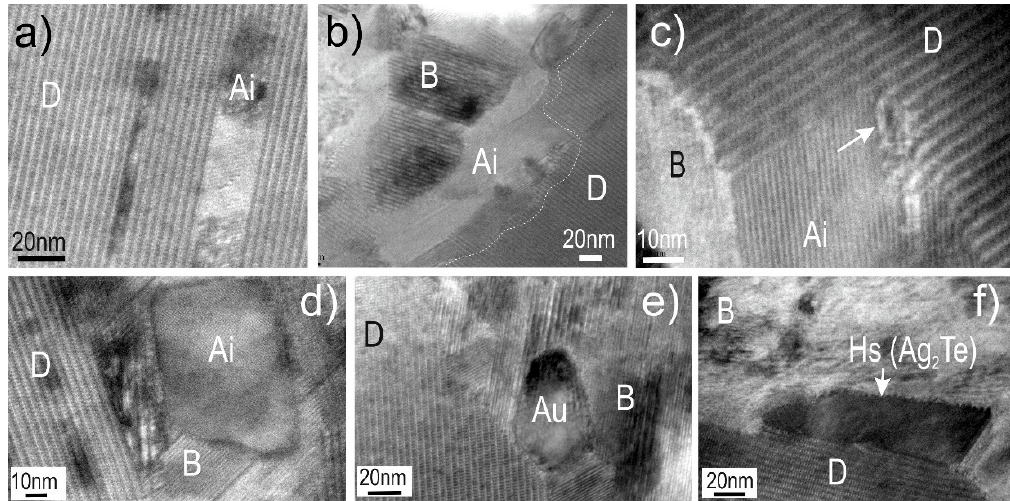
Figure 9. BF HR-TEM images showing replacement relationships between aikinite (Ai) and the two Pb-Bi-sulphosalts (D and B) ( a , b , d ); defects along phase boundaries ( c ) and inclusions of native gold ( e ) and hessite Hs; ( f ) at grain boundaries. See the text for additional explanation.